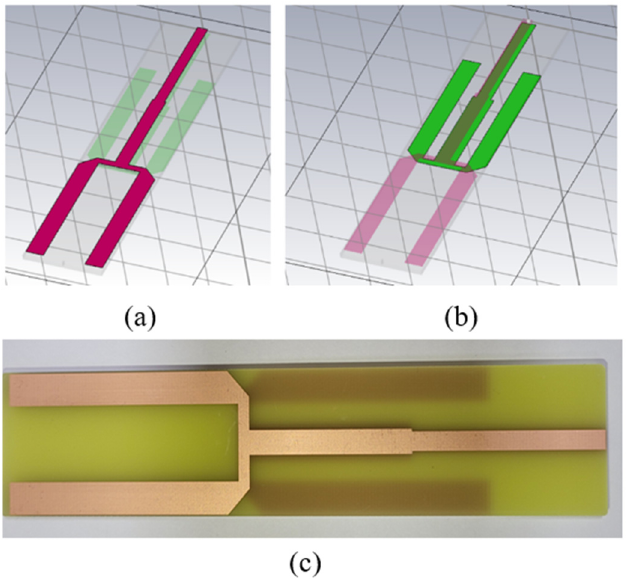
Figure 3. Structure of the collinear antenna; ( a ) Top view in simulation, ( b ) bo tt om view in simula- tion, ( c ) printed collinear antenna. ( c ) printed collinear